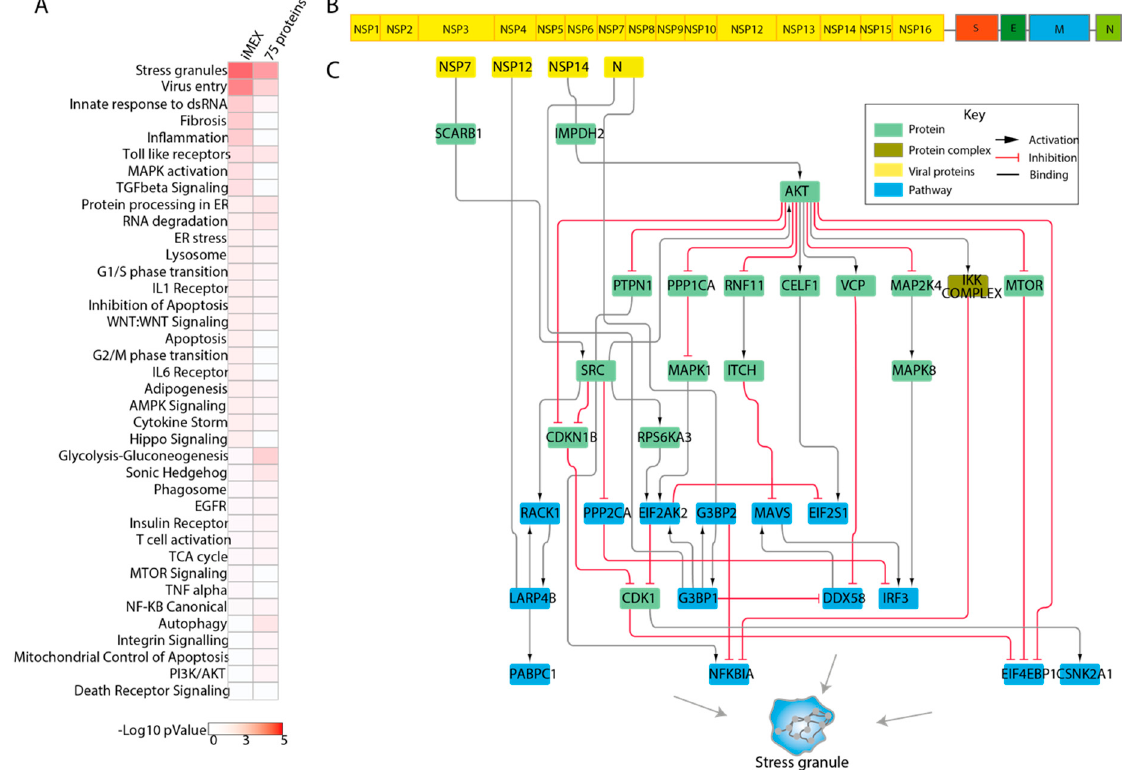
Figure 4. Inferred causal paths linking viral proteins to cellular pathways. ( A ) Heatmap illustrating the − Log( p -values) of pathway proximity enrichment of the two interactor lists considered in our approach. The right and left columns report in a red to white color scale the − Log10 p -value of the enriched pathways identified in the list of the 75 protein hits and the 116 protein interactors curated by the IMEx consortium respectively. ( B ) Schematic illustration of the SARS-CoV-2 genome. ( C ) Graph representation of the inferred functional paths underlying the modulation of stress granule formation in human host cells by SARS-CoV-2 interactors. Viral proteins are in yellow. The proteins that are annotated to the “stress granule” pathway are in blue. In green are the human proteins that bridge the viral proteins to the proteins annotated to the stress granule